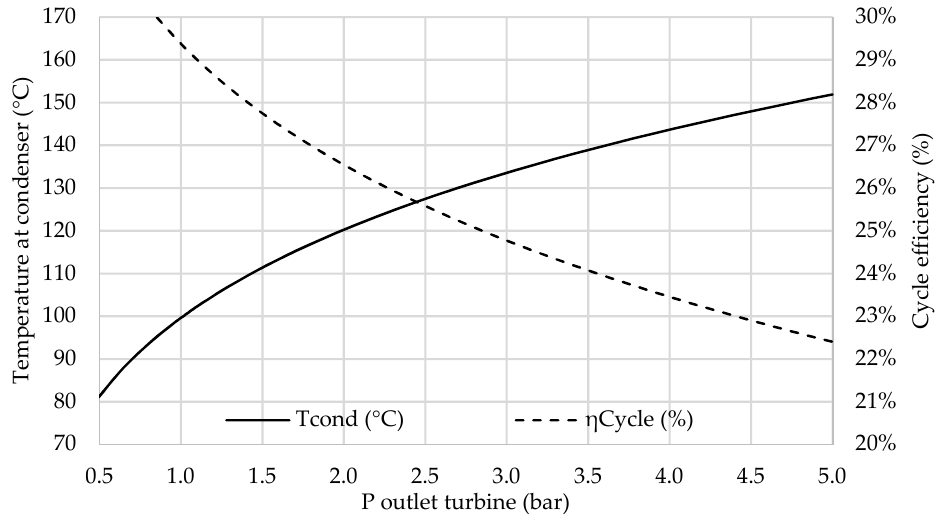
Figure 10. Temperature at the condenser of the Rankine cycle (T cond , left axis) and cycle efficiency (η Cycle , right axis) as a function of turbine’s discharge pressure.